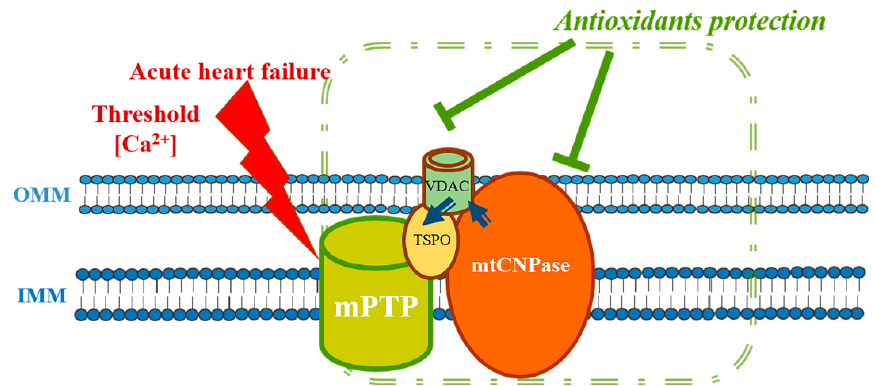
Figure 4. Role of CNPase in the development of acute heart failure.